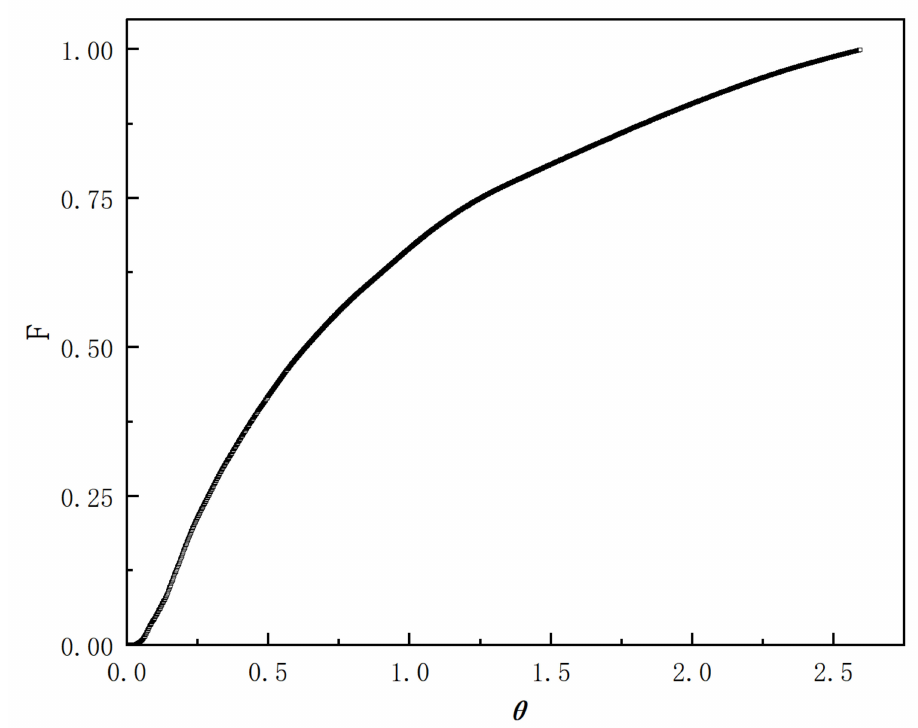
Figure 7. Classic tundish F